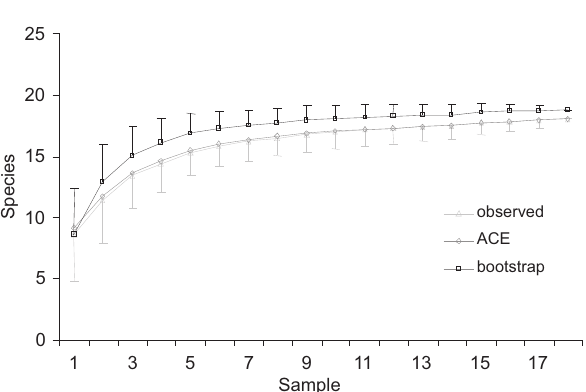
Figure 2. Bootstrap and ACE estimators for 18 sampling periods between September 2004 and August 2005 in Icém, São Paulo. Curves were generated with 500 randomizations. Bars represent the standard deviation.